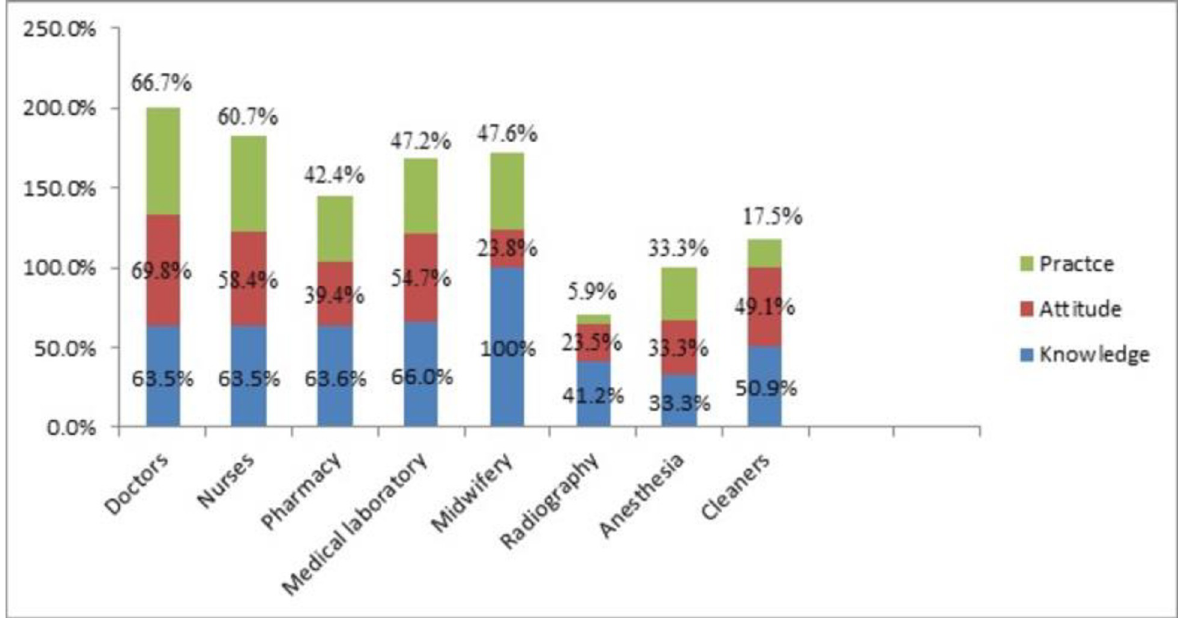
Fig 2. Frequency distribution of knowledge, attitude and practice of BMWM among HCWs in metropolitan cities private hospitals of Amhara region 2020.